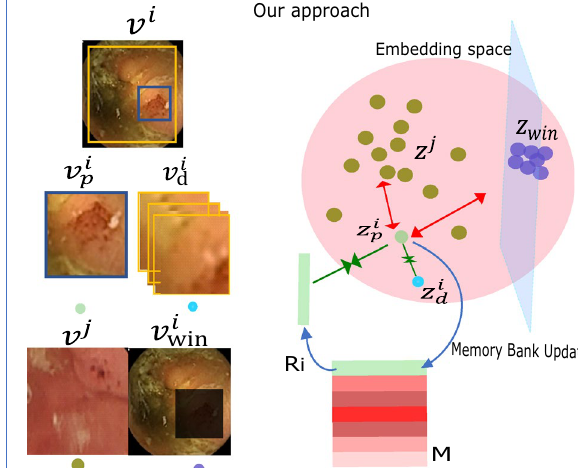
Figure 1. Proposed approach: given an unlabeled WCE image v i , we use priors to create special views namely a pathology-aware view v i p , a pathology-ignorant view v i win and a distorted view v i d . z ∗ ∗ denotes the encodings of these views. We use combinations of these views with contrastive objectives to strategically emphasize on pathology features during training. The resulting feature space (pink circle) shows how pathology-aware features z i z j dominate the output space and push away from pathology-ignorant features z win . We show the real p and contrastive space and analyze its properties Fig. 3 and “Embedding space analysis” section.